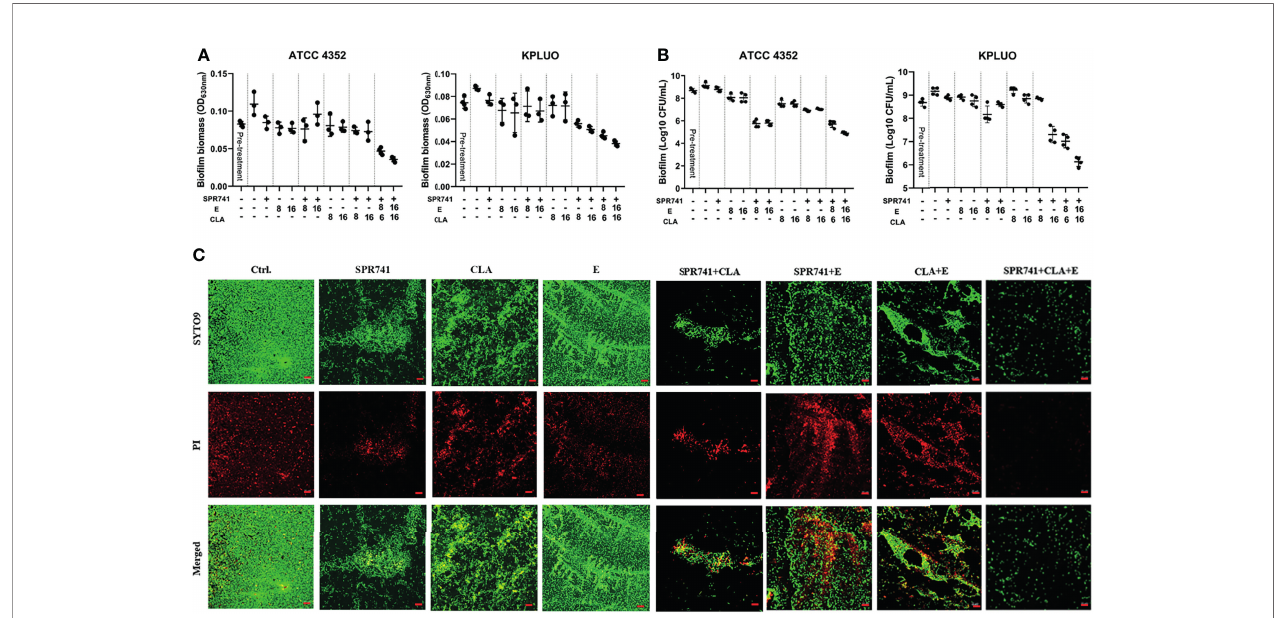
FIGURE 5 | Synergistic bio fi lm eradication and killing activity of SPR741, in combination with CLA and E, against K. pneumoniae . Effects of 8 µg/mL SPR741 combined with CLA (8/16 µg/mL) or E (8/16 µg/mL), in terms of eradicating 48 h pre-formed bio fi lm (A) and cell-killing (B) , in K. pneumoniae ATCC 4352 and XDR strain KPLUO. Experiment was repeated three times. (C) Representative CLSM images of anti-bio fi lm effects of SPR741+CLA+E-based mono, double or triple combination against ATCC 4352. Scale bar: 20